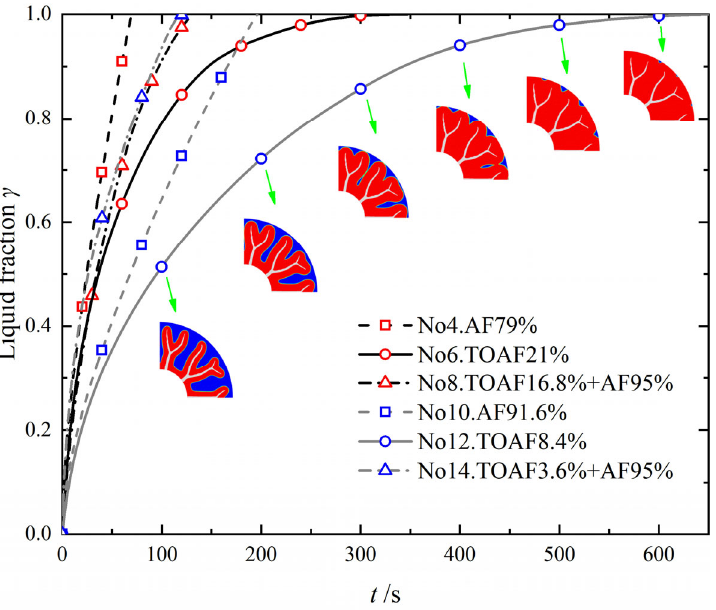
Figure 8. Liquid fraction vs. time for different alternatives.